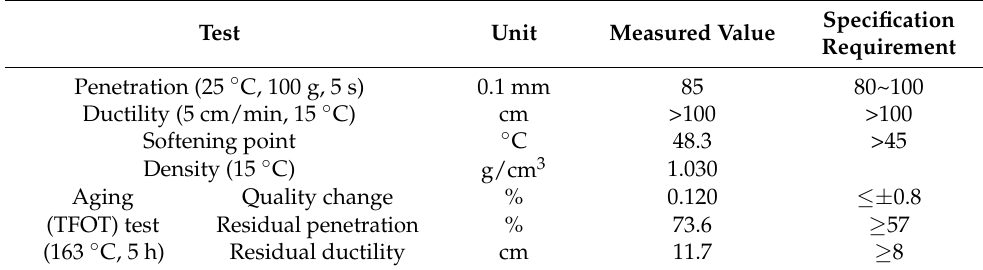
Table 1. Basic performance indexes of SK-90# asphalt.